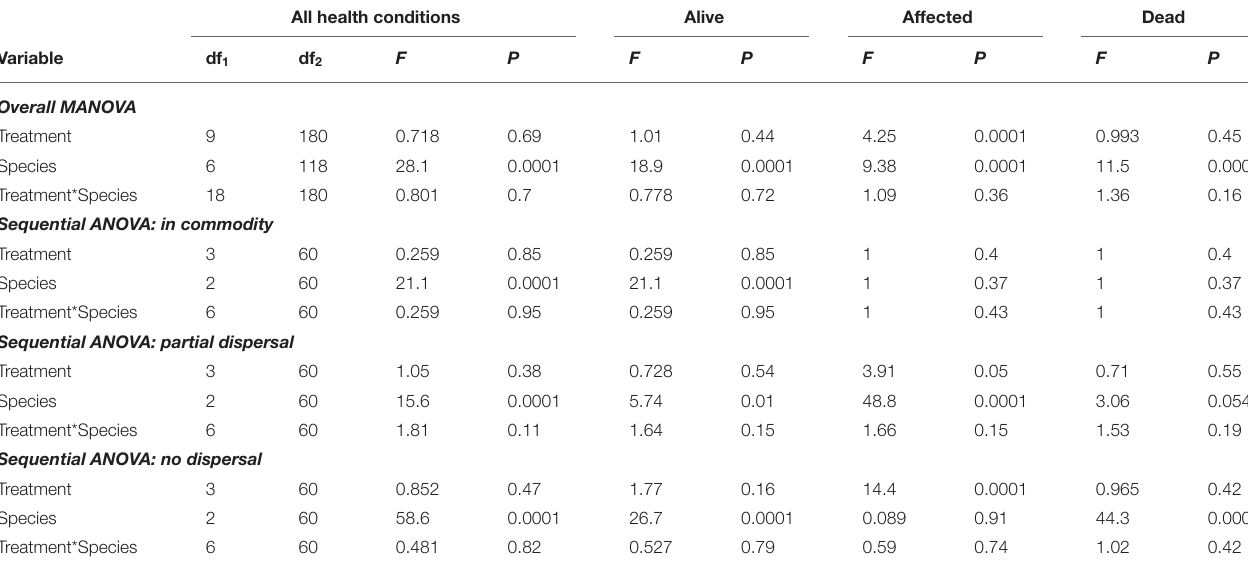
TABLE 5 | Statistical model results for recapture of individuals in the commodity, partially dispersing, and not dispersing in the Trial 2 examining management tactic efficacy in a pilot-scale warehouse release-recapture assay deployed in 2019 in Manhattan, KS. All health conditions Alive Affected